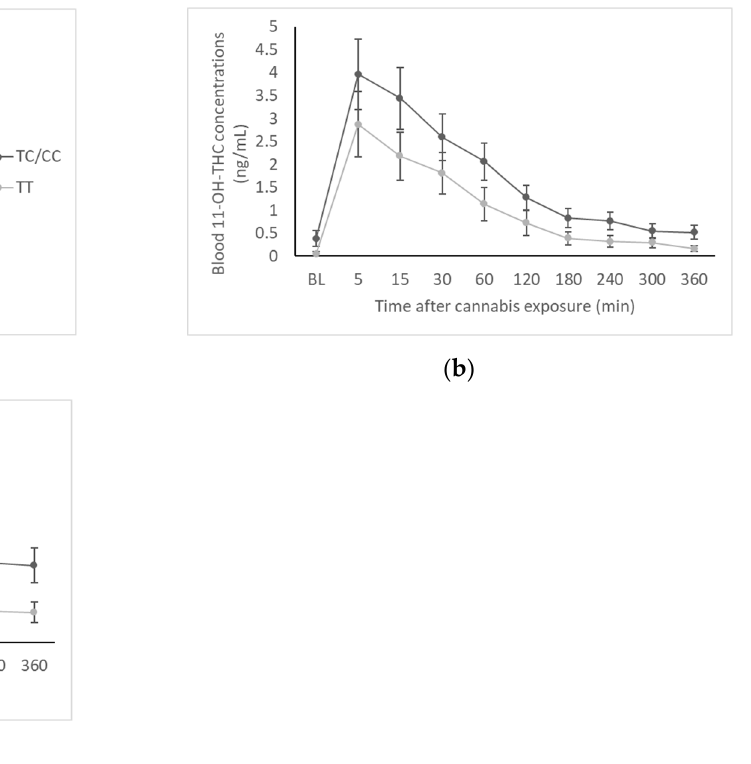
Figure 1. Blood cannabinoid concentrations by genotype group. ( a ) Whole-blood concentrations of THC at baseline and for 6 h (360 min) following exposure to cannabis; ( b ) Whole-blood concentra- tions of 11-OH-THC at baseline and for 6 h (360 min) following exposure to cannabis; ( c ) Whole- blood concentrations of THC-COOH at baseline and for 6 h (360 min) following exposure to canna- bis. Table 2. Pharmacokinetic